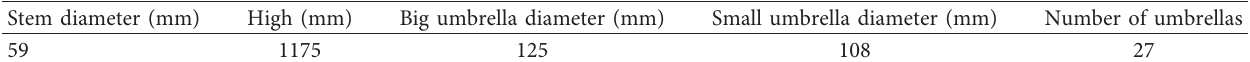
Table 5: Main dimensions of pillar porcelain insulator.